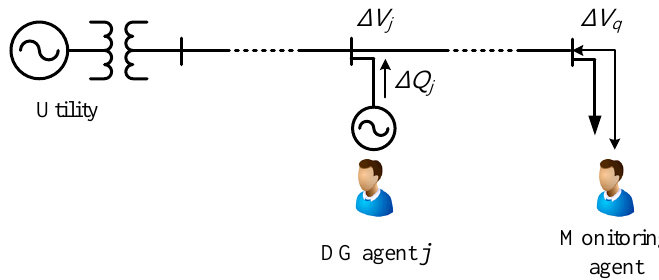
Figure 3. An example showing the method to calculate Q s